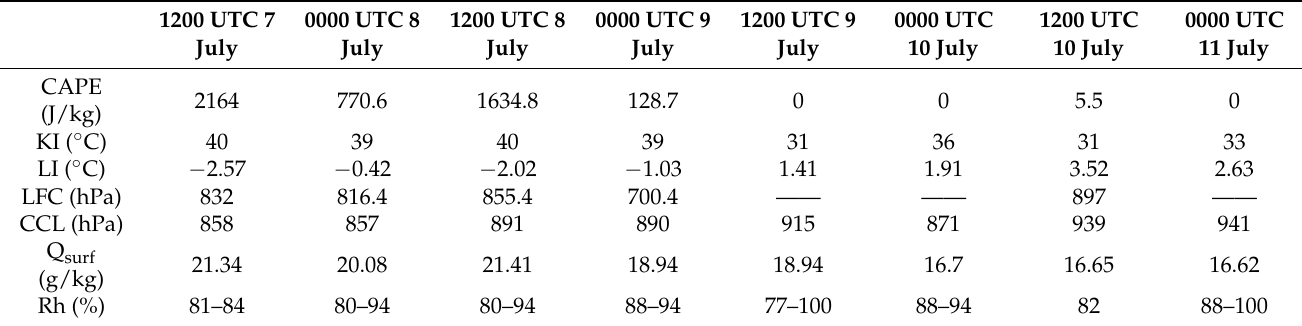
Table 1. Physical value variation of MCSs based on sounding-station data: CAPE, CIN, KI, LI, level of free convection (LFC), convection condensation level (CCL), surface vapor mixing ratio (Q surf ), and relative humidity